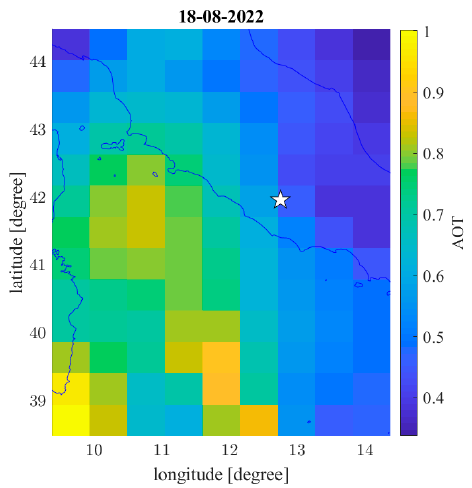
Figure 3. The aerosol map on 18 August 2022. The epicentre of Guidonia 1 January 2023 earthquake is shown with a white star.